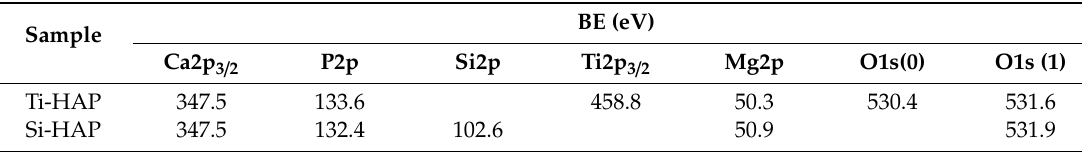
Table 2. Photoemission peaks of the HAP samples.